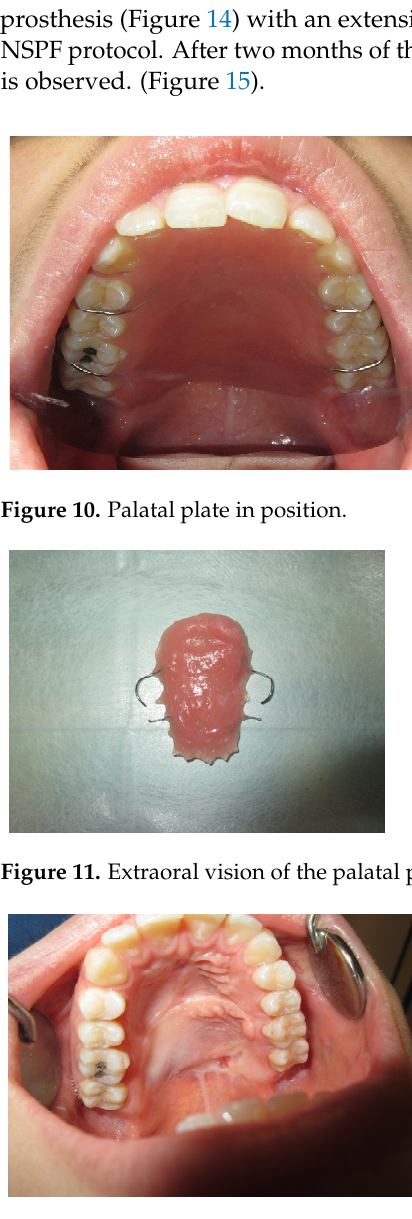
Figure 12. Intra-oral vision after 2 months.